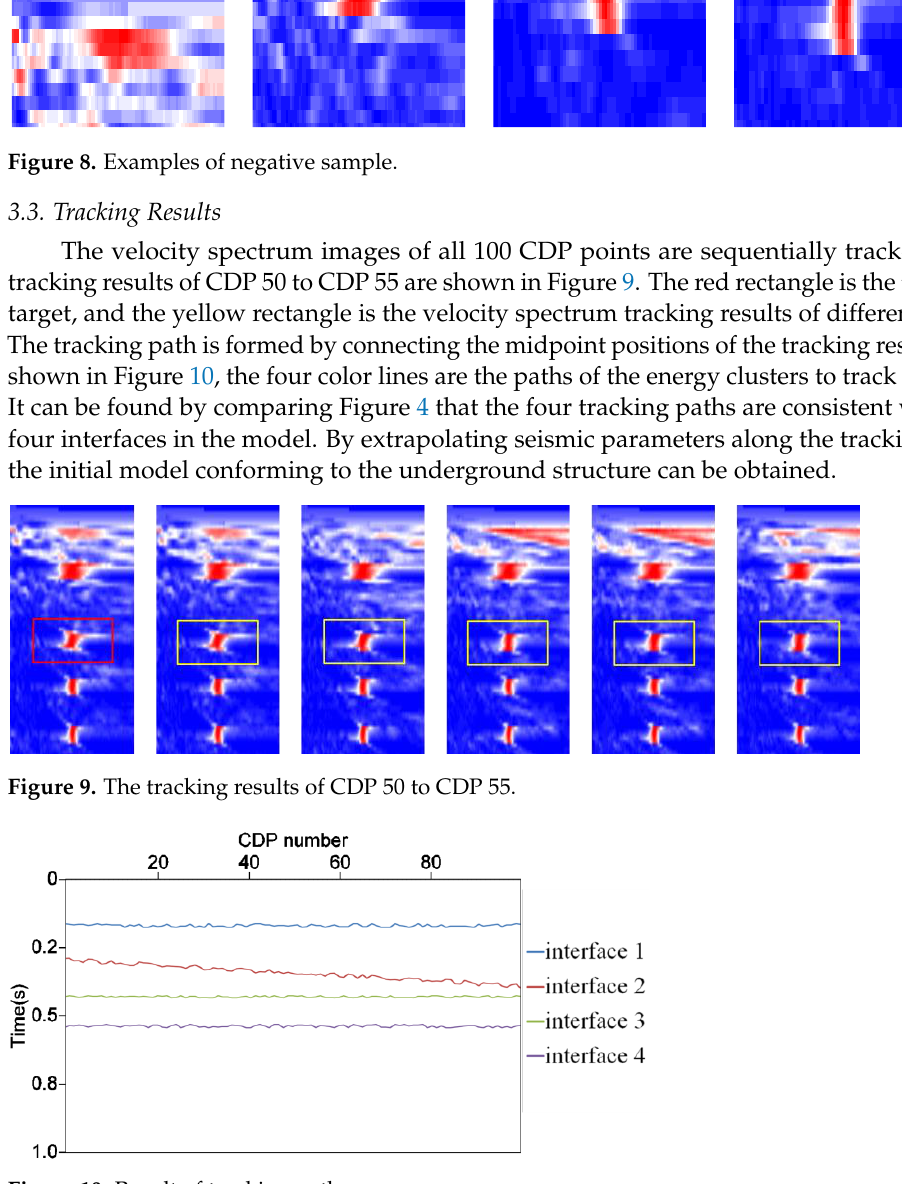
Figure 7. Examples of positive sample. ( a ) Tracking target image; ( b ) image after 1.5 times stretch- ing; ( c ) image after 3 times stretching; ( d ) image after low-pass filtering; ( e ) image after bandpass filtering; ( f ) image after high pass filtering.